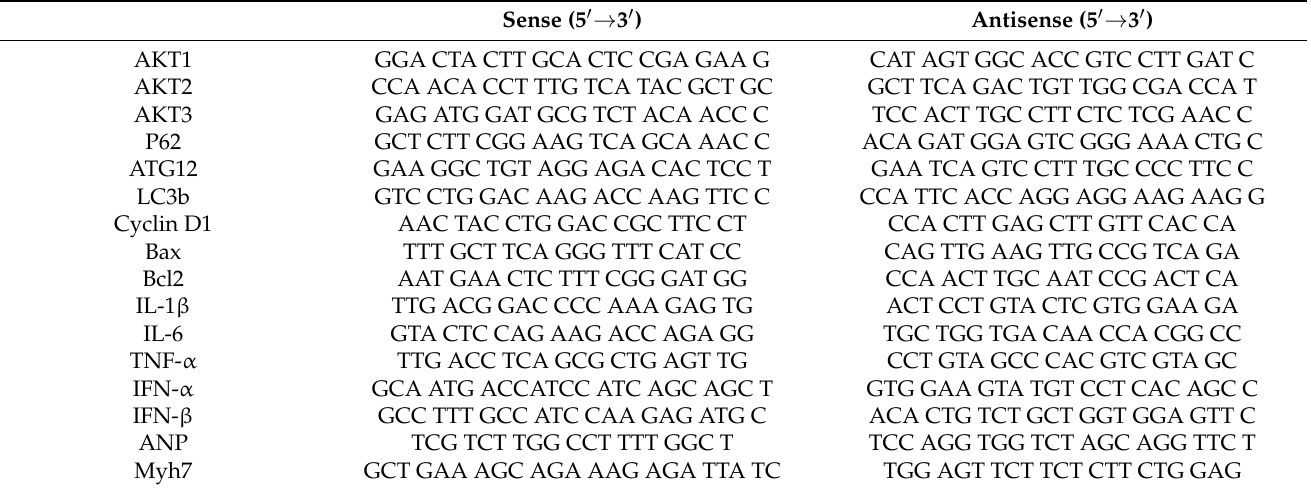
Table 1. Real-time PCR primer sequences. Sense (5 (cid:48) → 3 (cid:48)